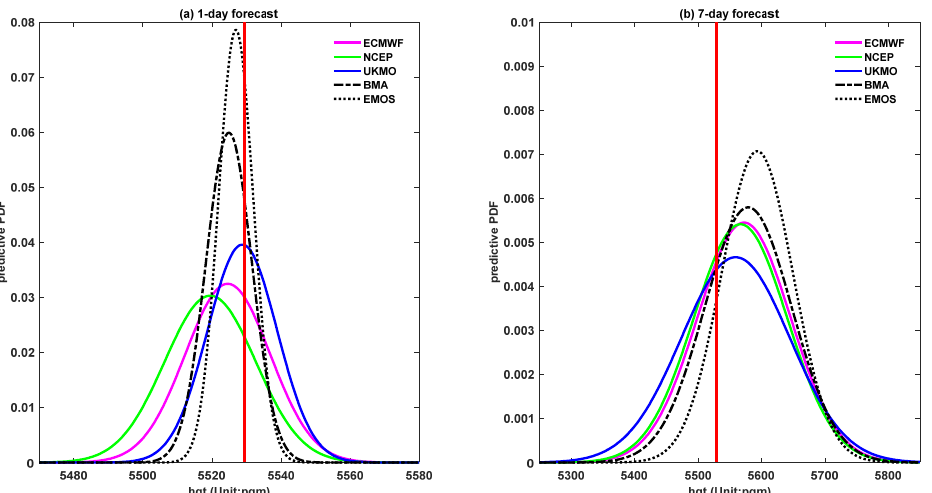
Figure 3. Predictive probability density function (PDF) of the 500 hPa geopotential height for (72.5° N, 42.5° E) on 8 July 2013 obtained from the BMA, EMOS and raw ensemble forecasts with lead times of ( a ) 1 day and ( b ) 7 days. The red vertical line represents the verifying observation. The BMA weights of ECMWF, NCEP, and UKMO EPSs with lead time of 1 day (7 days) are 0.3052 (0.4195), 0.32 (0.3431), and 0.3749 (0.2375), respectively.